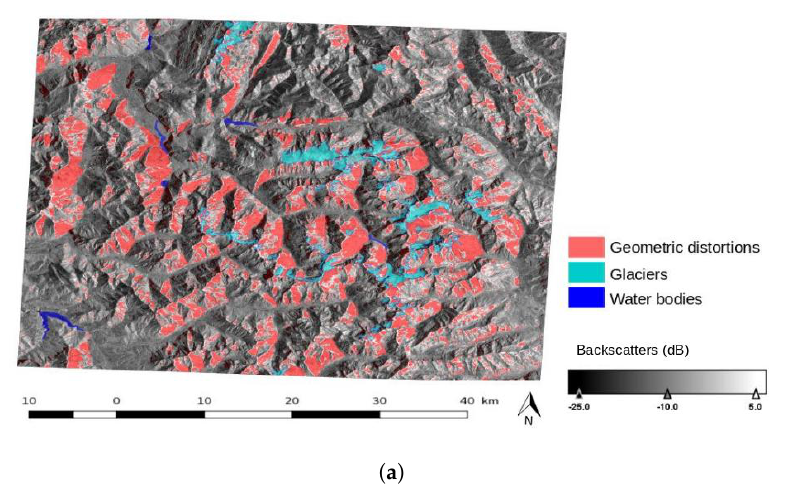
Figure 2. CORINE Land Cover products at 25m resolution over our study area with the massifs delimitations, stations and the area of 2900 m used in Section